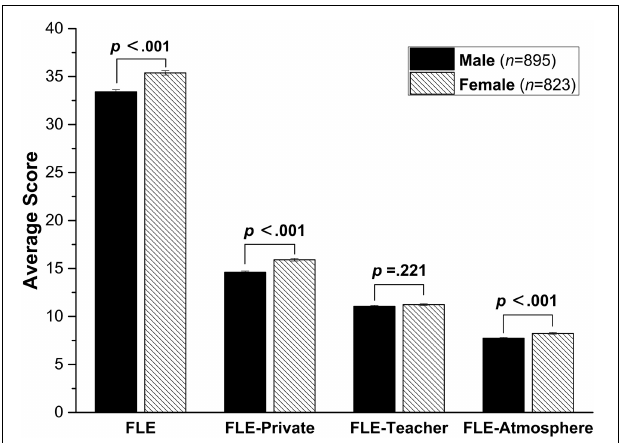
FIGURE 1 | Gender differences in foreign language enjoyment (Error bars represent standard